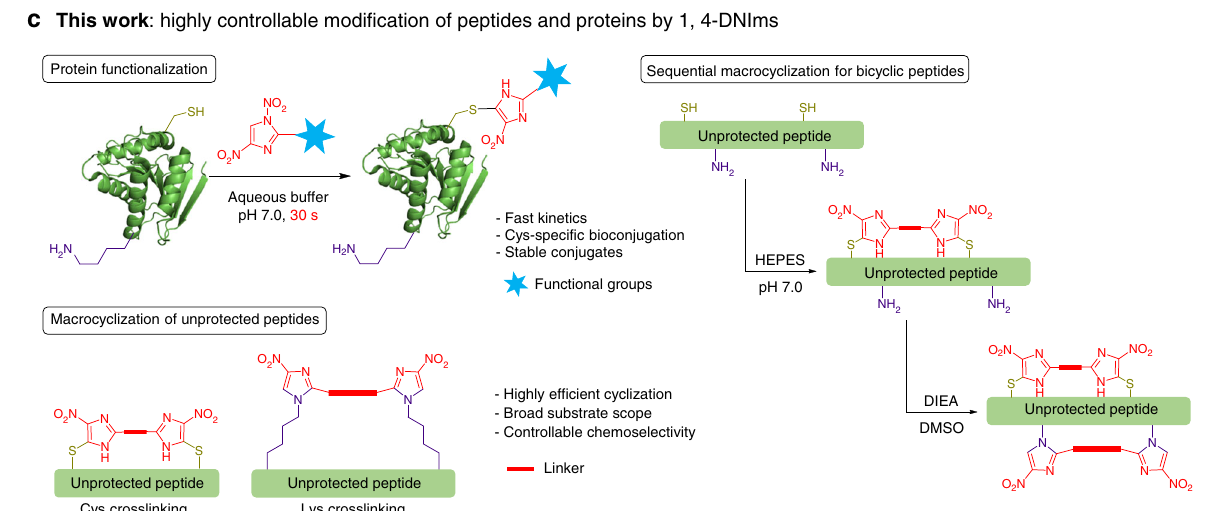
c This work : highly controllable modification of peptides and proteins by 1, 4-DNIms